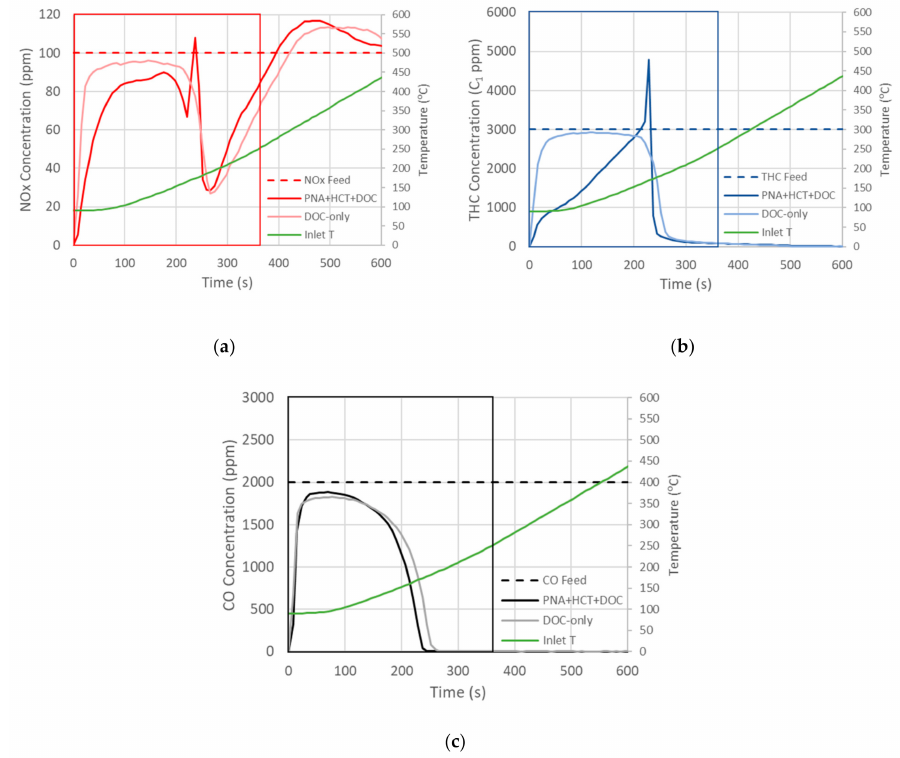
Figure 1. Time-based reactor effluents for ( a ) NO, ( b ) THC, and ( c ) CO during temperature ramps for DOC-only and PNA + HCT + DOC reactor beds; temperature plotted on right y -axis. Boxes indicate area that is below 250 ◦ C and is the primary focus for reactivity